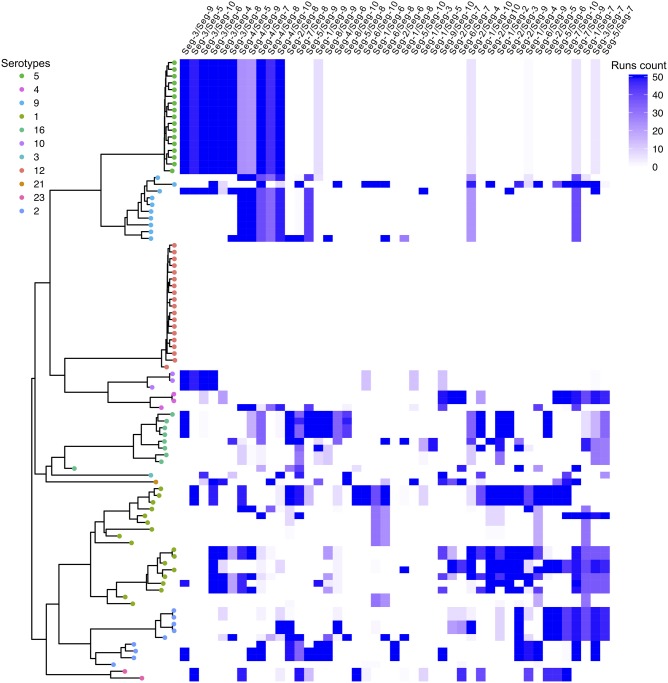
Tree topology inconsistencies between pairs of Indian BTV segments. Inconsistencies in tree topologies, indicative of genome reassortment, were identified using the program GiRaF (Nagarajan and Kingsford 2011). The number of independent runs (out of 50) with evidence of inconsistency is shown between each possible pair of segments (columns) for each BTV sample (rows). Samples are ordered according to the Seg-2 MCC tree (i.e. by serotype, Fig. 1). Segment pairs were ordered by reassortment pattern similarity using hclust, the Ward minimum variance clustering method, and Ward’s clustering criterion (Murtagh and Legendre 2014).